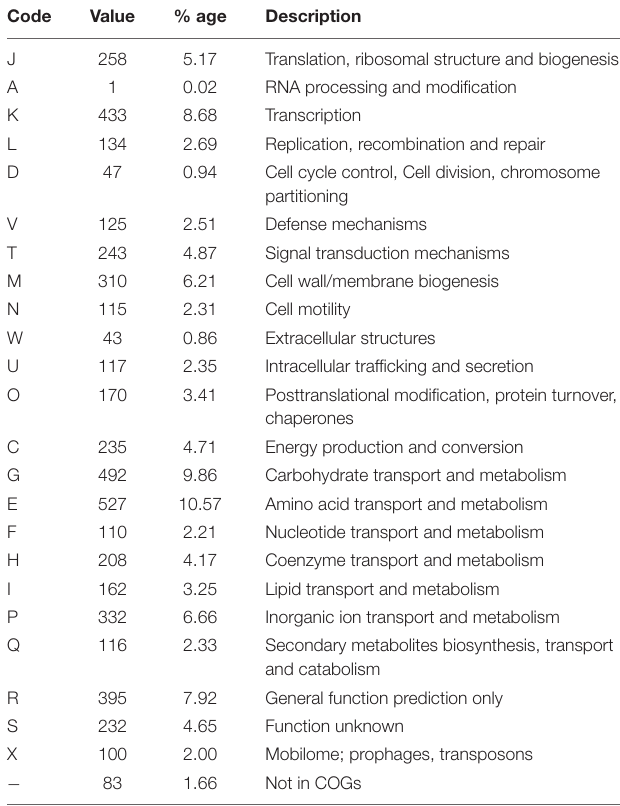
TABLE 1 | Number of genes associated with general COG functional